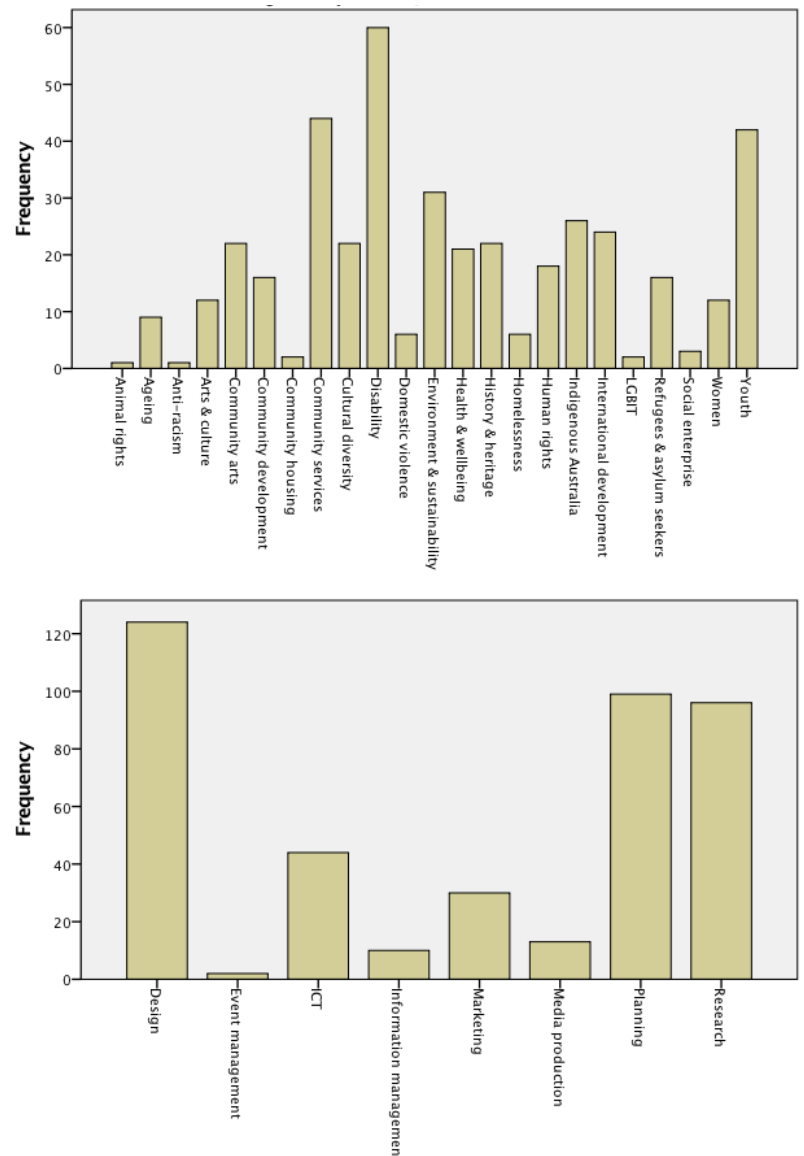
Figure 2: Community